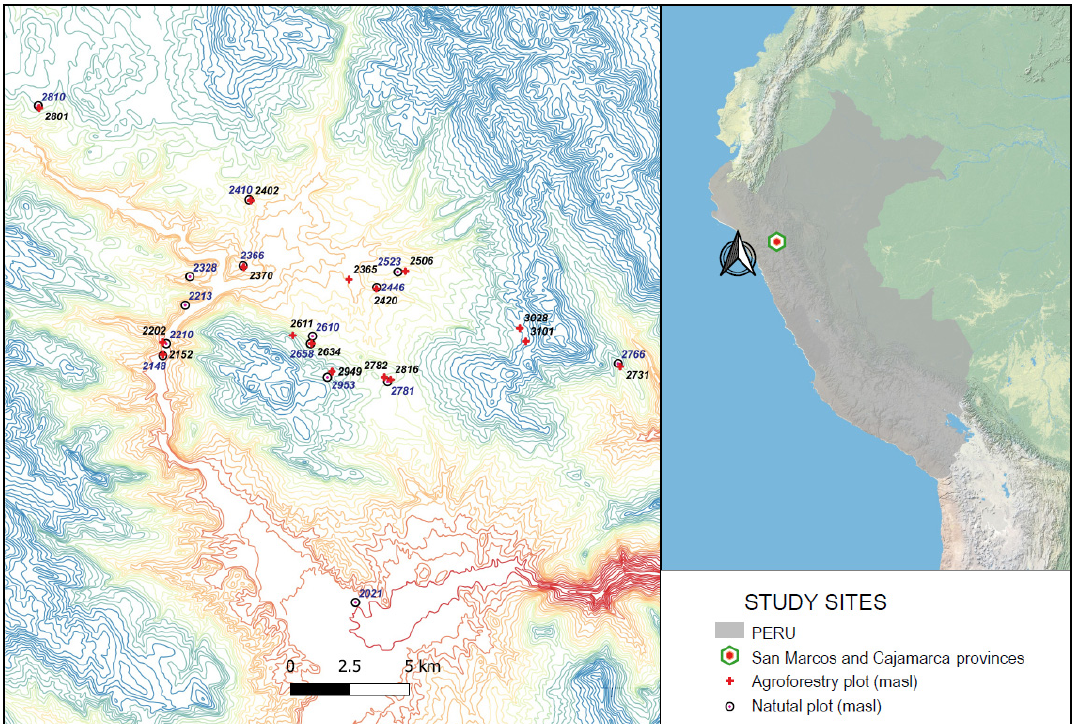
Figure 1. Location of the study area and distribution of plots in the region of Cajamarca, Andes,